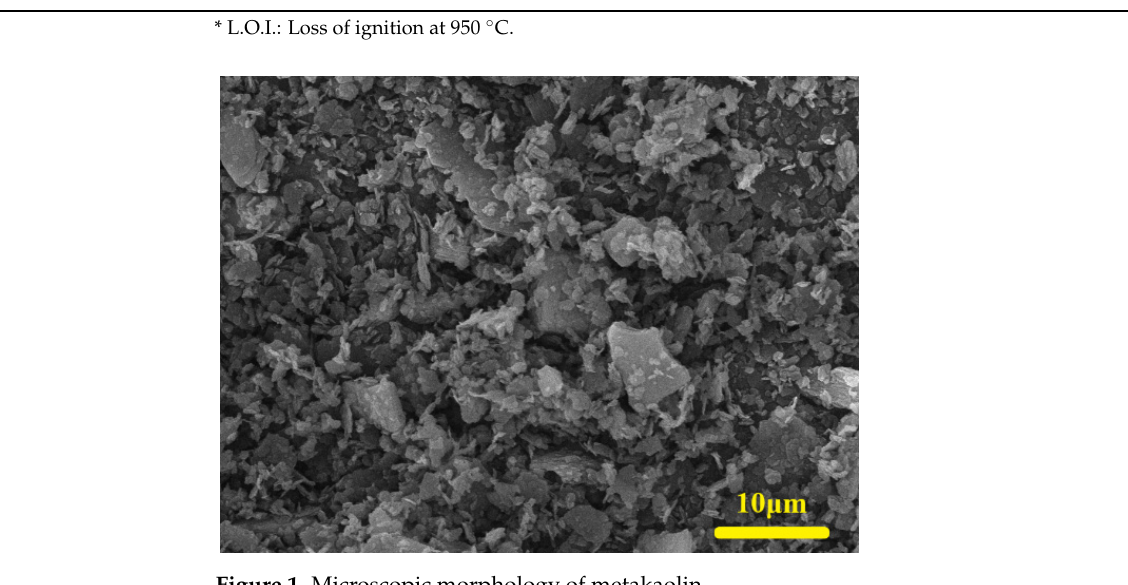
Figure 1. Microscopic morphology of metakaolin.